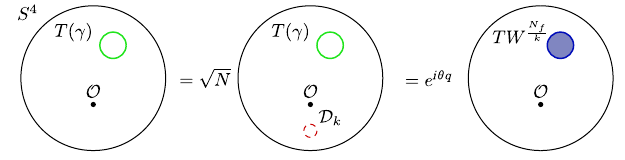
FIG. 2. A noninvertible symmetry transforms a line operator T on a line γ into a line operator attached to a surface